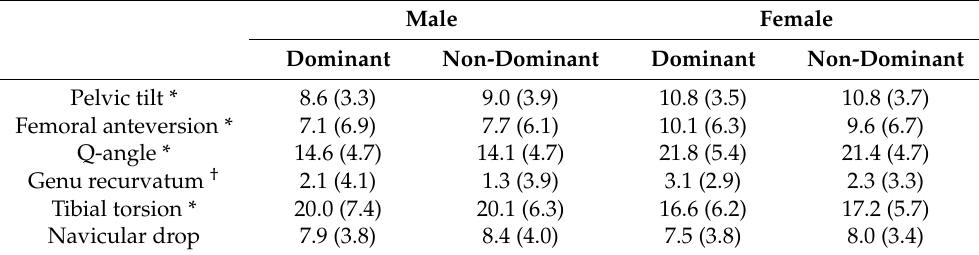
Table 2. Lower extremity alignment measurements for sex and